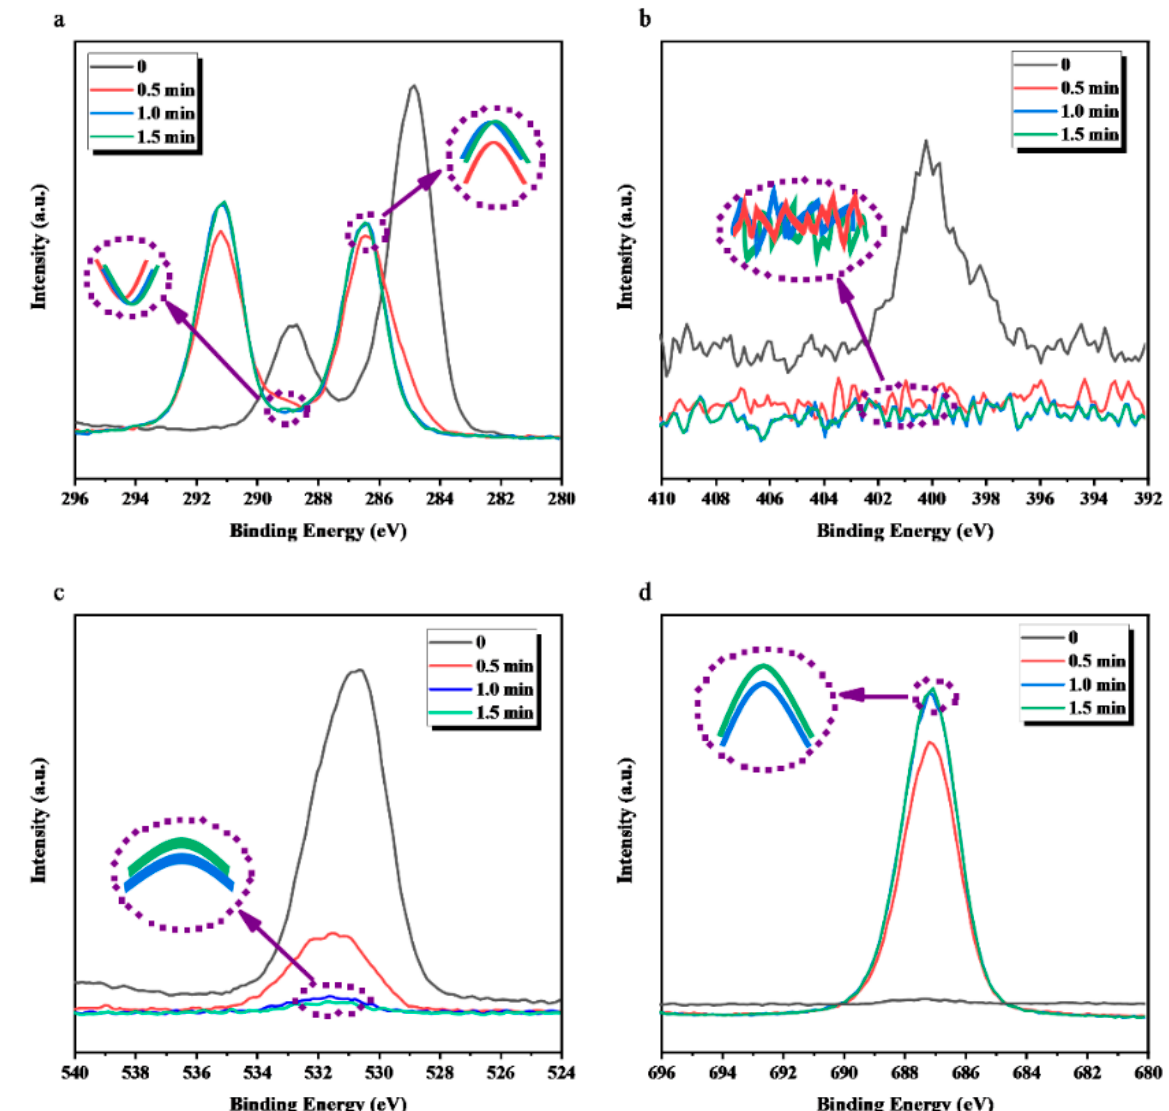
Figure 7. Comparison of peak intensity for each element on the surface of ETFE-3 membrane in a function of sputtering time: ( a ) C, ( b ) N, ( c ) O, and ( d ) F.